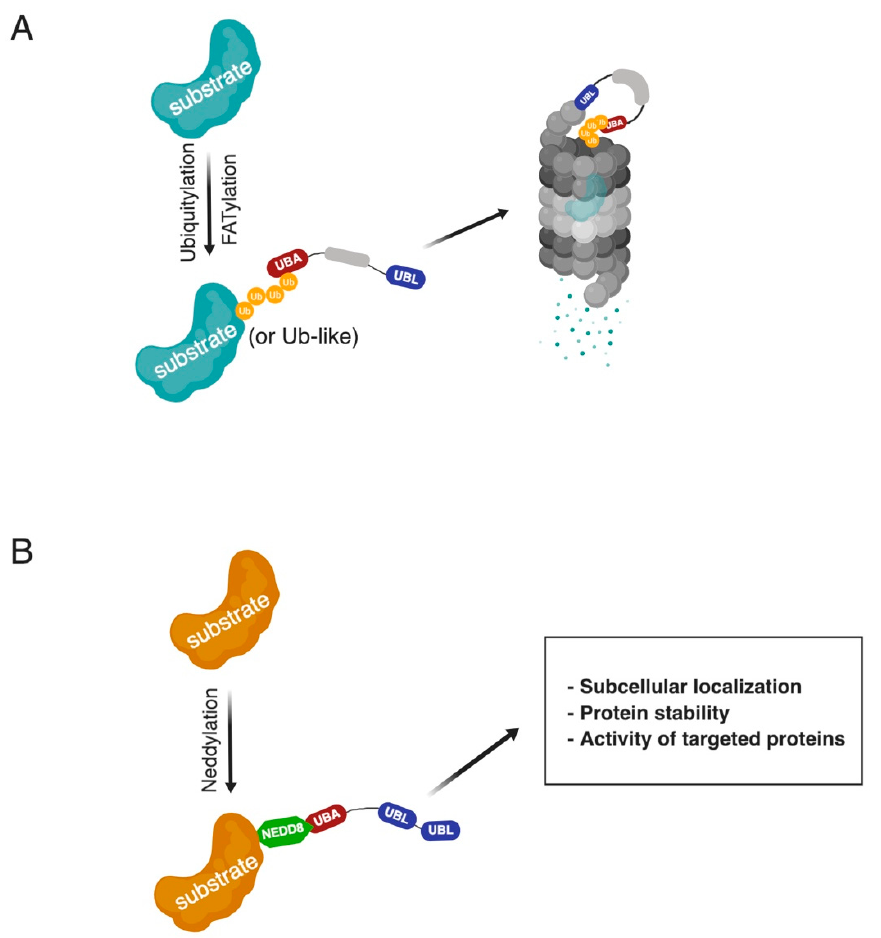
Figure 1. Paradigm towards the regulation of UbL-UbA proteins. ( A ) Ubiquitylated and FATylated substrates are bound to UbL-UbA proteins before their degradation by proteasomes. Like the ubiquitylation, “FATylation” is a post-translational modification in which FAT10 forms a covalent bond with its target proteins. ( B ) Neddylated substrates are bound to the UbA domain of NUB1 in order to facilitate localization or stability and promote other activities. Table 1. Protein identities of Drosophila and human UbL-UbA proteins. The primary structures of UbL-UbA members were examined using the Expasy Prosite SIM alignment tool for protein sequences (www.expasy.org / sim) with default